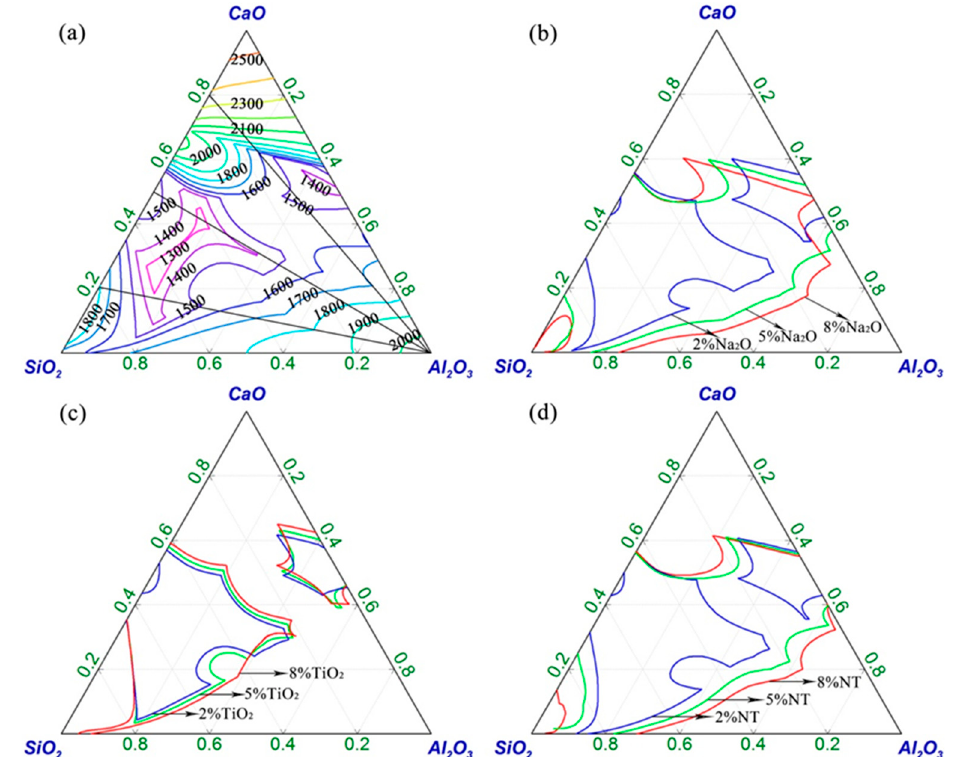
Figure 1. ( a ) Liquid areas of the CaO-SiO 2 -Al 2 O 3 slag system between 1200 ◦ C and 2600 ◦ C, ( b ) effect of Na 2 O on the CaO-SiO 2 -Al 2 O 3 slag system at 1500 ◦ C, ( c ) effect of TiO 2 on the CaO-SiO 2 -Al 2 O 3 slag system at 1500 ◦ C, ( d ) effect of NT on the CaO-SiO 2 -Al 2 O 3 slag system at 1500 ◦